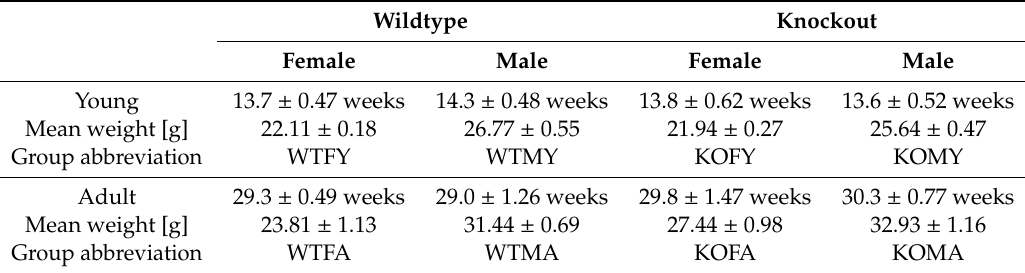
Table 1. Overview of animal biometric